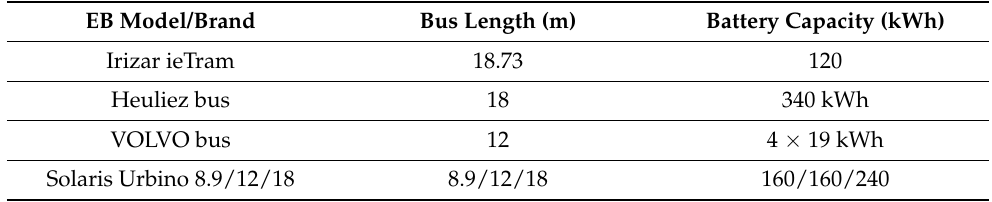
Table 4. Battery packs adopted in some BEBs in the ASSURED project